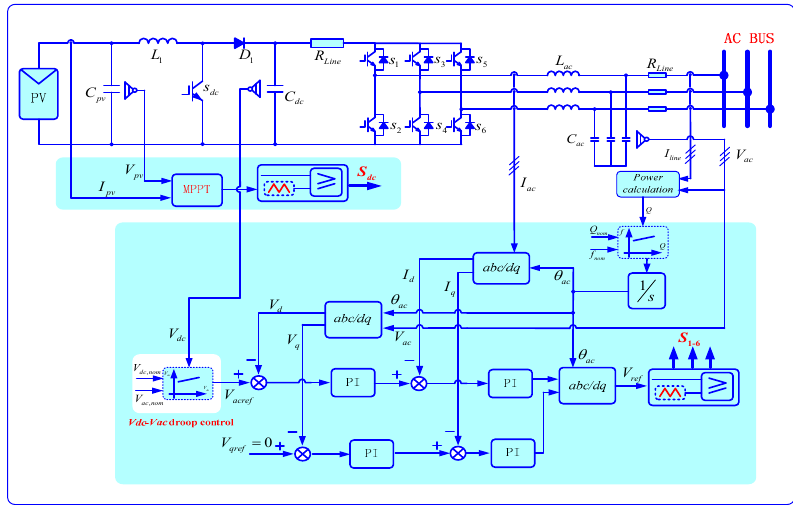
Figure 4. The overall scheme of the alternating current (AC) ‐ side PV generator in hybrid microgrid.